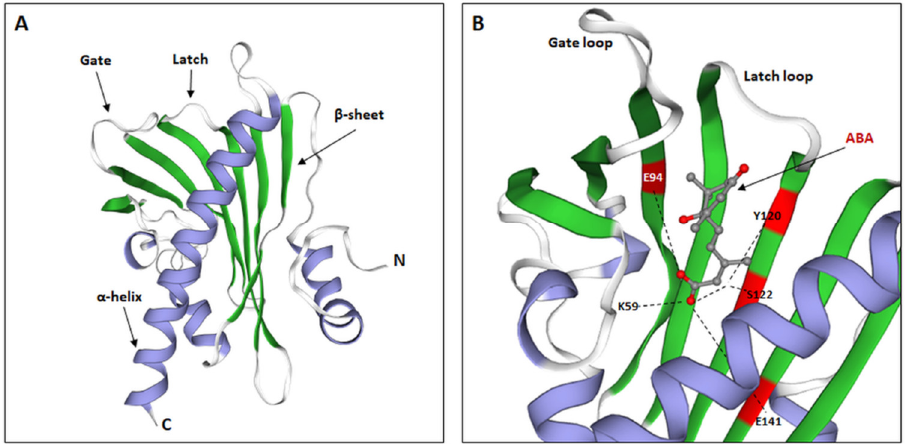
Figure 4. ABA receptor structure. ( A ). Structure of the monomeric, apo-form of Festuca elata PYR1 (FePYR1), showing a secondary structure: α -helixes, β -sheets, and two main loops, involved in the ABA binding: latch and gate. ( B ). Structure of AtPYR1 binding pocket, highlighting main amino acids involved in the interaction with ABA residues: K59, E94, Y120, S122, and E141. (Modified from [71]).